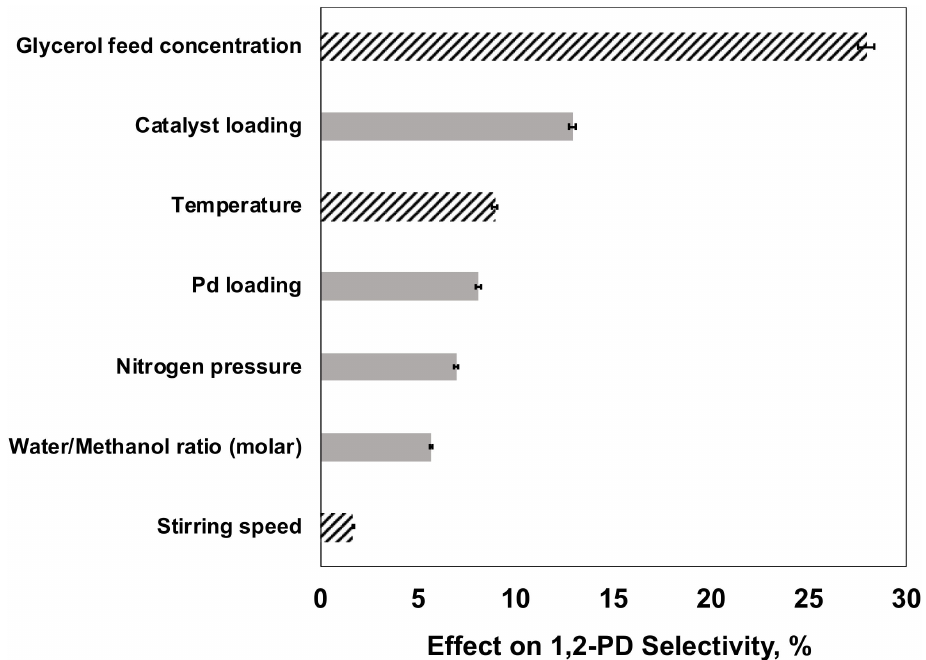
Figure 7. The effects of single-factors on 1,2-PD selectivity. (Solid bars) positive effects; (patterned bars) negative effects, error margin: 95% confidence